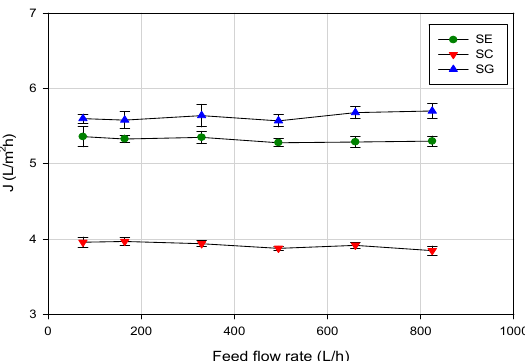
Figure 4. RO of evaporator condensate stream. Effect of feed flowrate on steady-state permeate flux (operating conditions: temperature, 20 ± 1 °C; TMP, 5 bar).